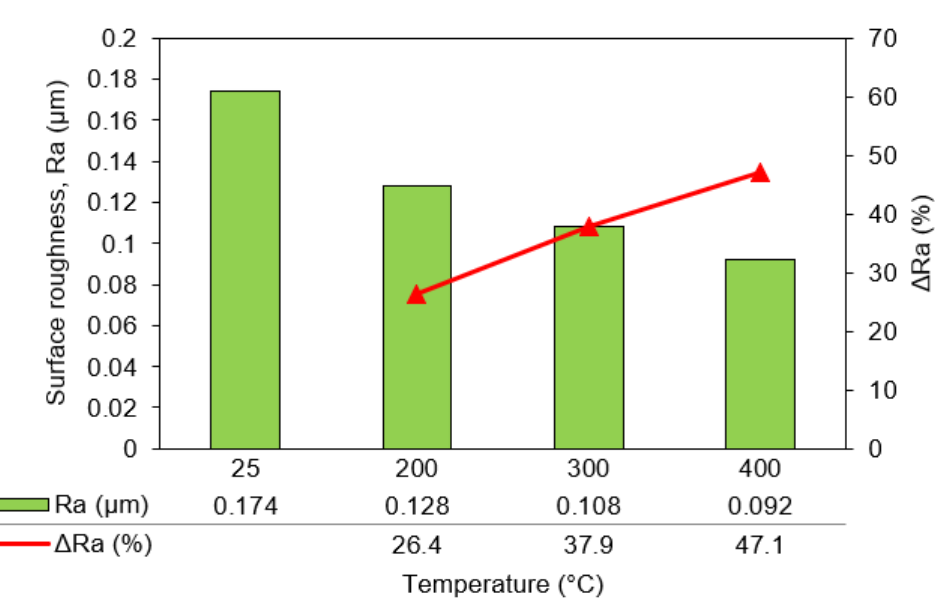
Figure 9. Measurement of Surface Roughness with Equipment and Method ( a ) and Comparison of Surface Roughness Pro fi les for Machining at Room Temperature ( b ) and 200 °C ( c ).